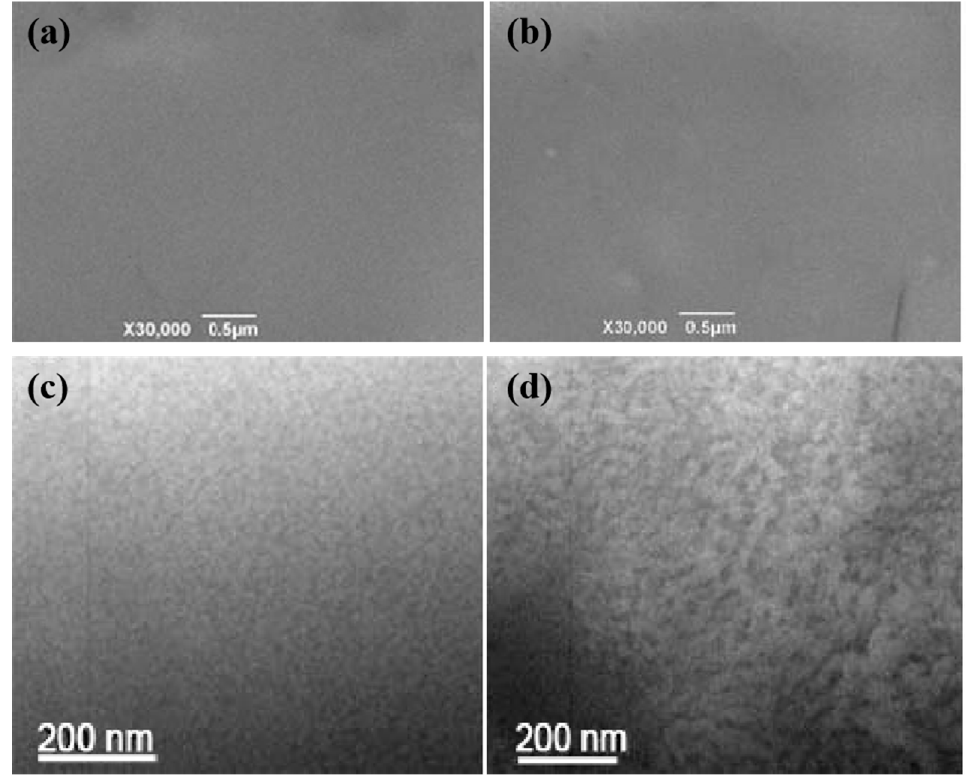
Figure 4. SEM ( a , b ) and TEM ( c , d ) images of ( a , c ) pristine S-SEBS and ( b , d ) H302:S-SEBS = 0.30:1 membrane.